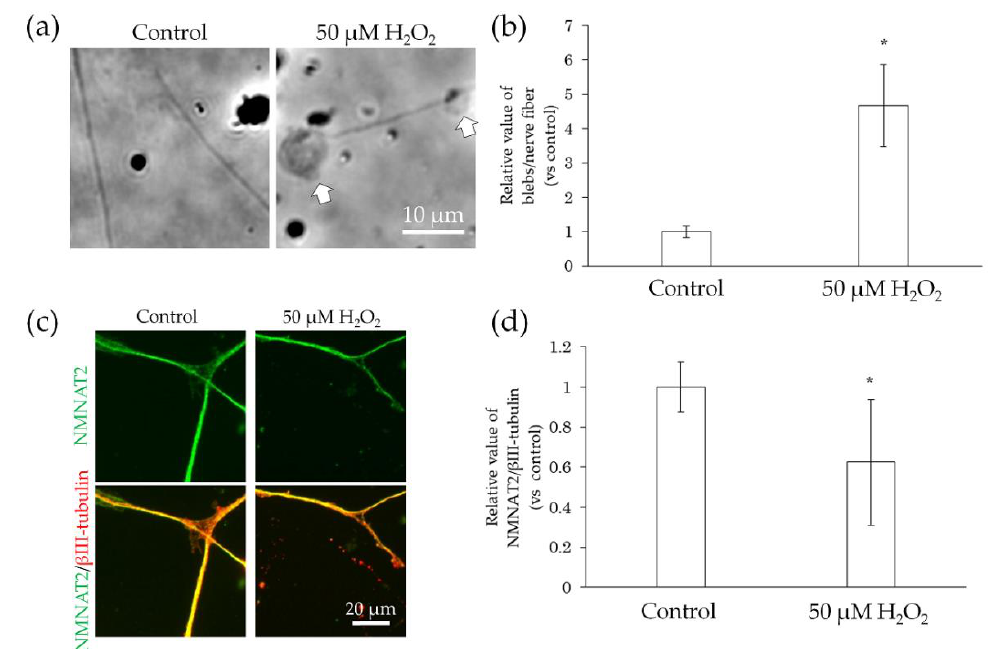
Figure 6. Effect of H 2 O 2 treatment on bleb formation and NMNAT2 expression in nerve fibers. After culturing for 3 days, the effects of the direct interaction between hiPSC-SN and H 2 O 2 were assessed. ( a ) Morphological changes in nerve fibers 24 h after treatment with H 2 O 2 . The arrows indicate blebs. ( b ) Number of blebs in 50 μM H 2 O 2 . ( c ) Double labelling of NMNAT2 (red) and βIII-tubulin (green) in nerve fibers with 50 μM H 2 O 2 . ( d ) NMNAT2-immunoreactive (ir) nerve fiber length normalised to βIII-tubulin-ir nerve fiber length in an identical area with 50 μM H 2 O 2 . * p < 0.05, vs. absence of H 2 O 2 (Welch’s t-test). Each value represents the mean ± standard deviation of more than three wells. H 2 O 2 : hydrogen peroxide; NMNAT2: nicotinamide mononucleotide adenylyltransferase 2.